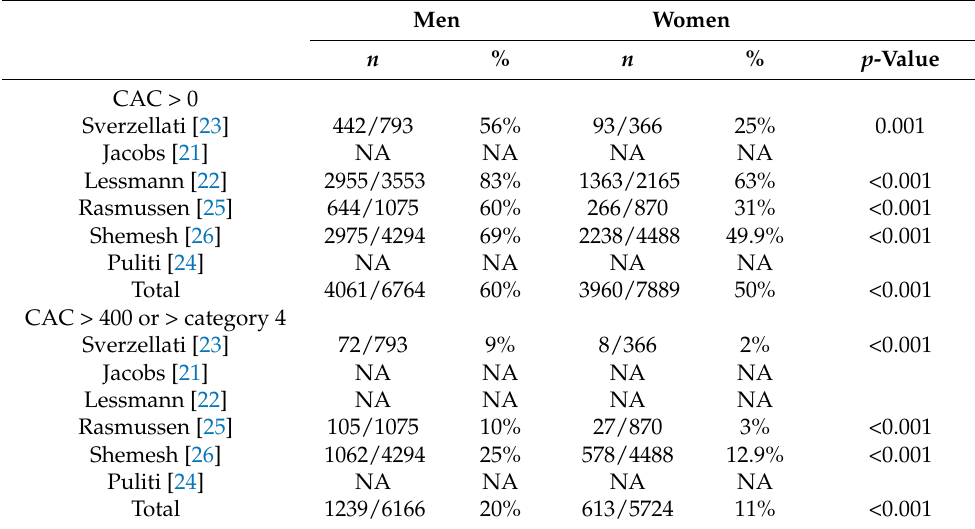
Table 4. Frequency of coronary artery calcifications (CACs) according to sex, when available.